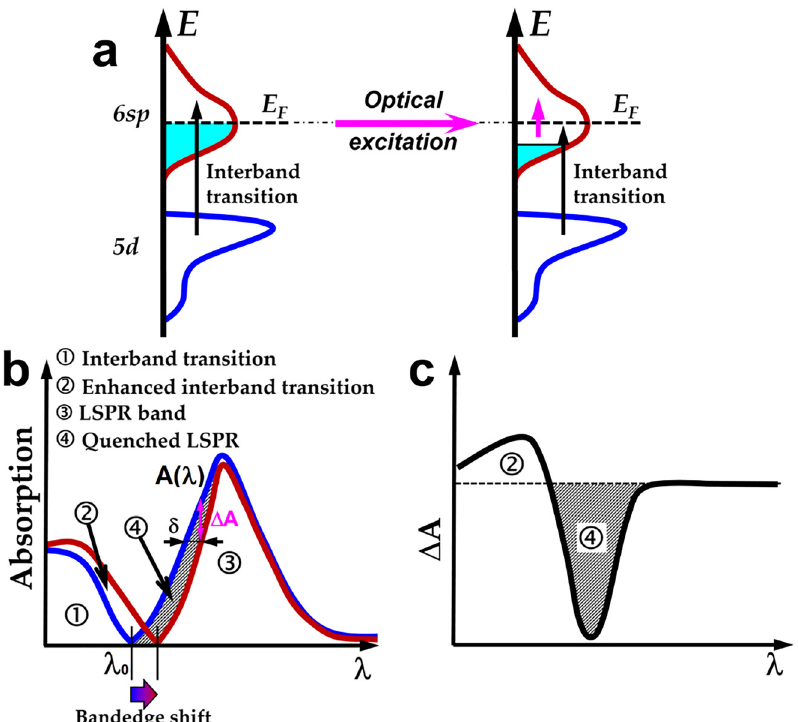
Figure 1: (a) Intraband optical excitation induced depletion of the conduction band below the Fermi level. (b) Redshift of the band edges due to the intraband depletion. (c) Bandedge shift induced enhanced interband transition ( ➁ ) and quenched plasmonic optical extinction ( ➃